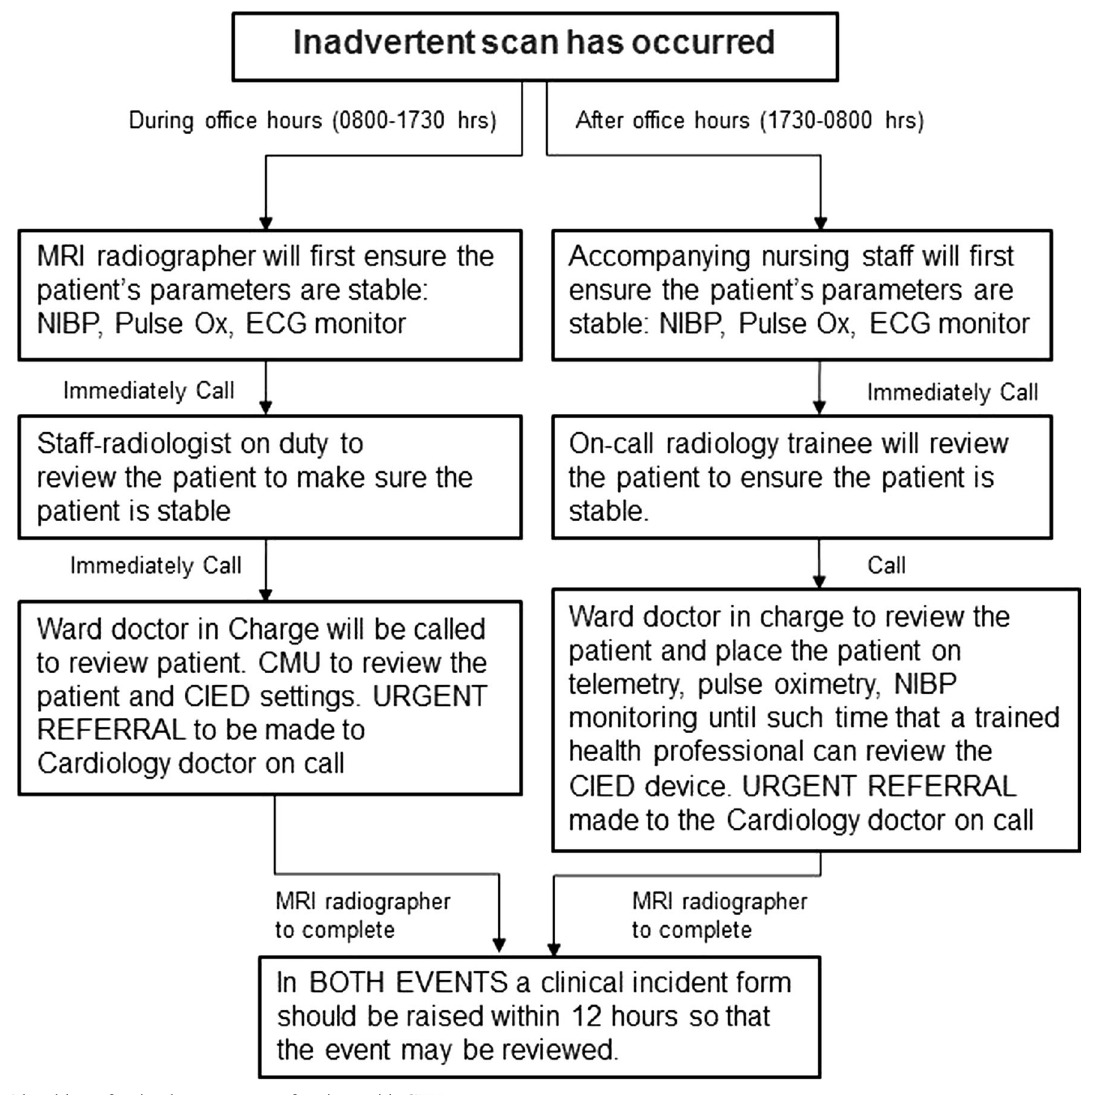
Fig. 18 Algorithm after inadvertent scan of patient with